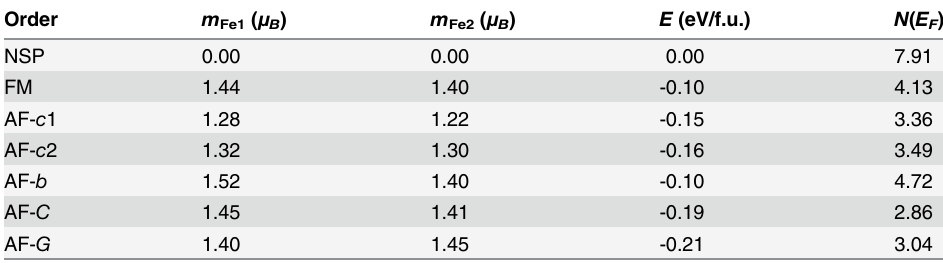
Table 1. Magnetic properties from GGA. Order